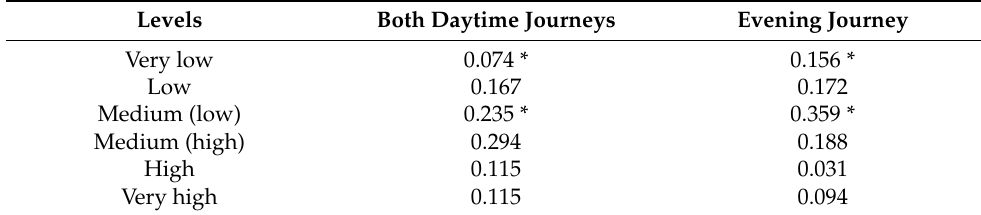
Table 5. Teachers’ ratio by technostress dimension Fatigue ( n = 3006).